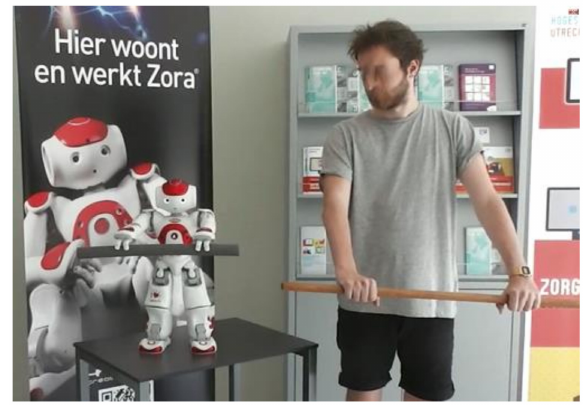
Figure 2. A demonstration of the robot Zora (student